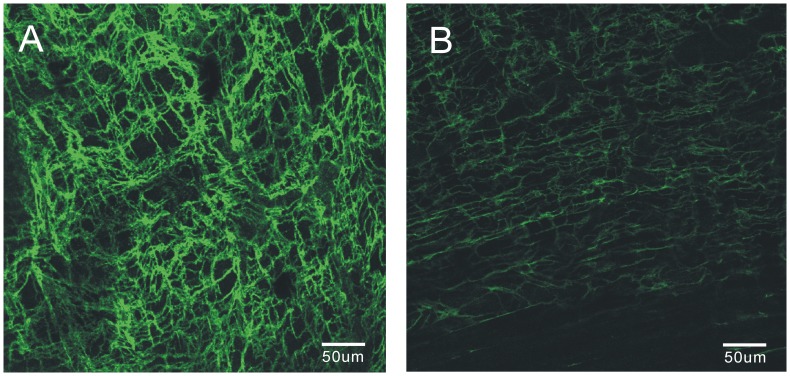
Fluorescent Immunohistochemistry of c-Kit in whole smooth muscle preparations.The control exhibited a dense network in the interstitial cells of Cajal (A), where this network was disrupted in the obstruction mice whole smooth muscle tissue (B).